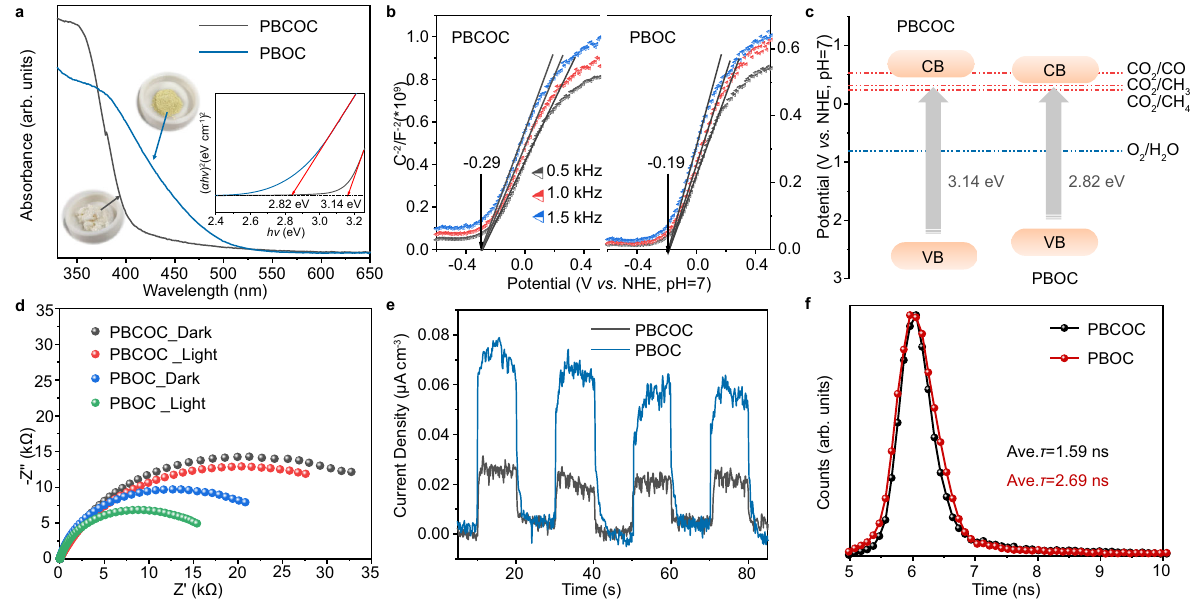
Fig. 3 Optical spectroscopy and photoelectrical properties of ultrathin PBOC layers and bulk PBCOC. a UV – vis diffuse re fl ectance spectra. Inset: corresponding optical images and obtained bandgaps of 2.82 and 3.14 eV, estimated by plotting ( α h ν ) 2 versus h ν . α and ν are the absorbance and wavenumber; h is the Planck constant. b Mott − Schottky plots. c Schematic illustration of the electronic band structures; grey arrows represent the electron transition process under the light irradiation. CB, conduction band; VB, valence band. d Electrochemical impendence spectroscopy. e Transient photocurrent densities with light on/off cycles under full spectrum in 0.1 M Na 2 SO 4 electrolyte solution at an applied potential of 0.5 V vs. Ag/AgCl electrode. f Time-resolved fl uorescence spectra. Ave. τ is the average fl uorescence